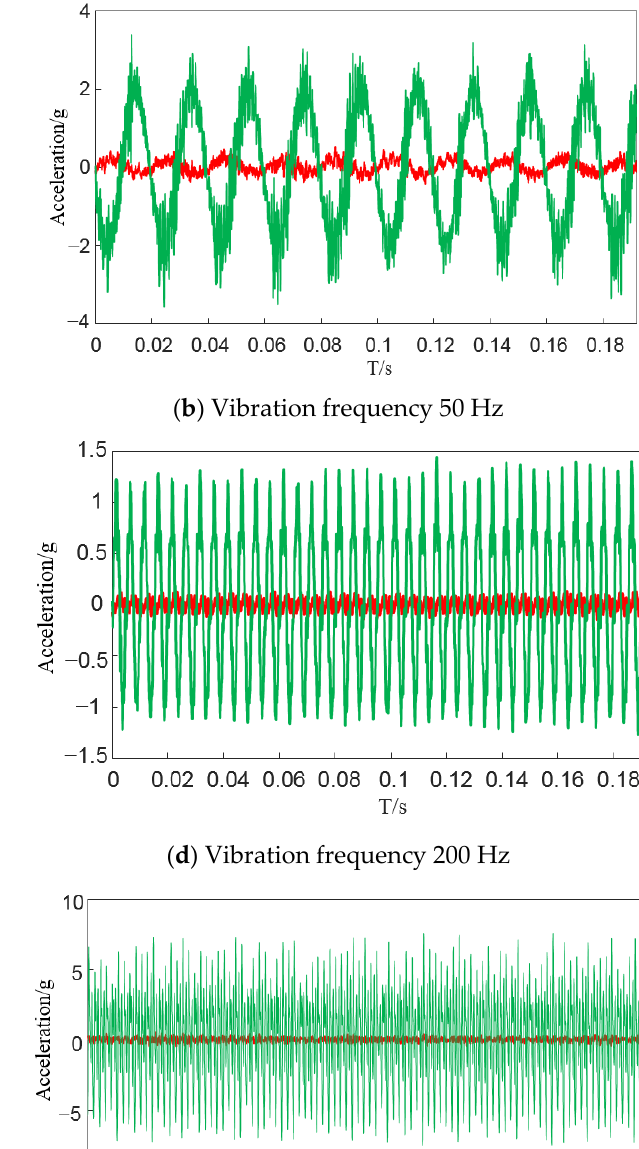
Table 11. Vibration attenuation rate and vibration transmission rate.